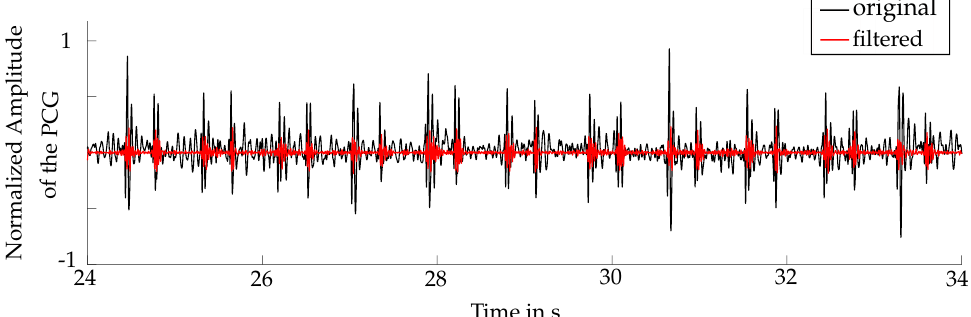
Figure 3. Comparison between the original phonocardiogram (PCG) in black and the bandpass filtered PCG in